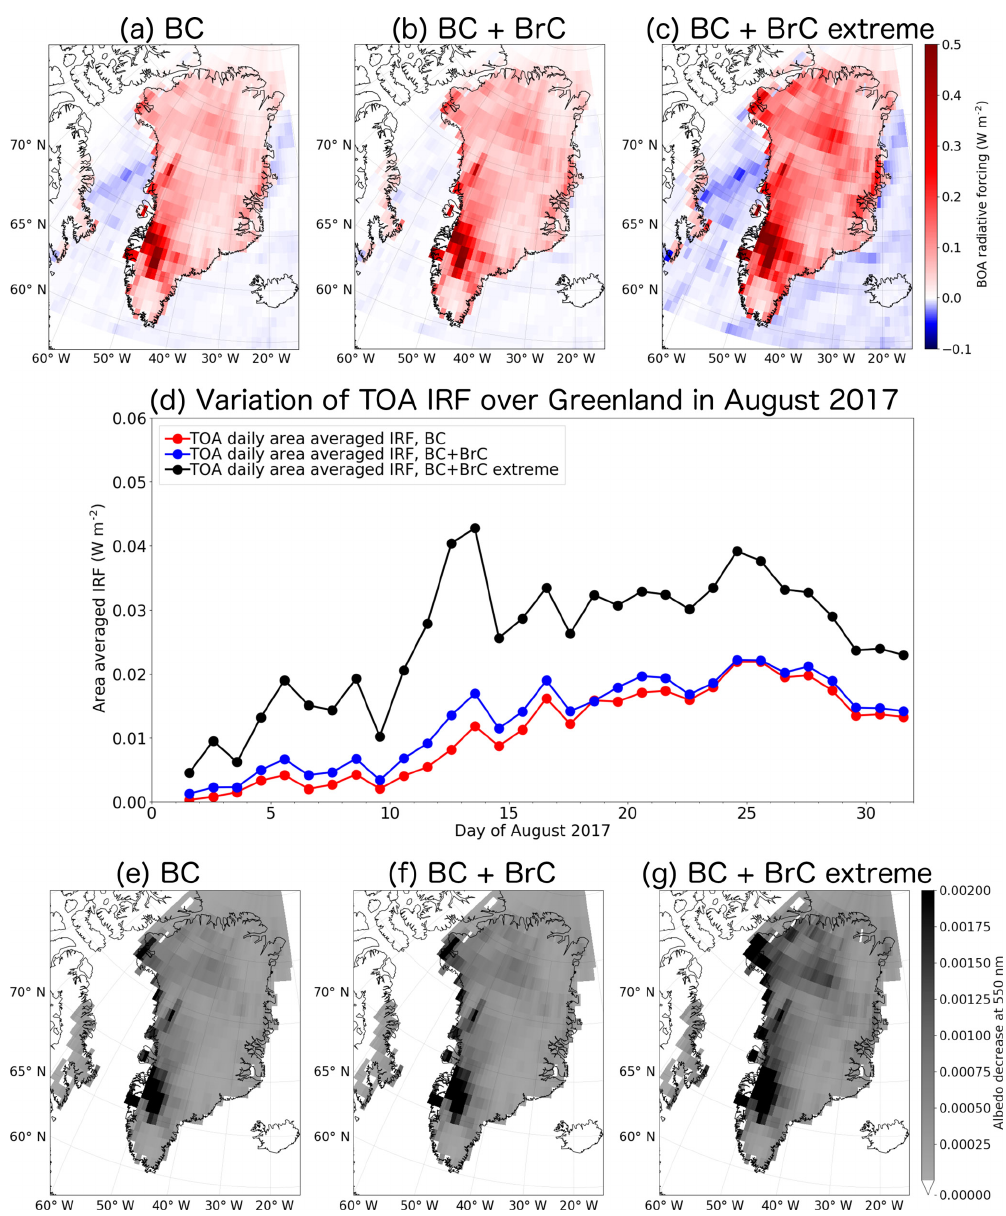
Figure 7. The instantaneous direct BOA RF due to (a) BC-only, (b) BC and BrC and (c) BC and BrC when OC was assumed to be all BrC (extreme case) from the Greenland fire for cloudy conditions on 31 August 2017. (d) Daily variation of the TOA IRF over Greenland in August 2017 for the three studied scenarios. Albedo reduction at 550nm due to (e) BC-only, (f) BC and BrC and (g) BC and BrC when OC was assumed to be all BrC (extreme case). Note that the maximum albedo change due to deposited smoke is 0.00585 (BC-only), 0.00590 (BC + BrC) and 0.00670 (BC + BrC